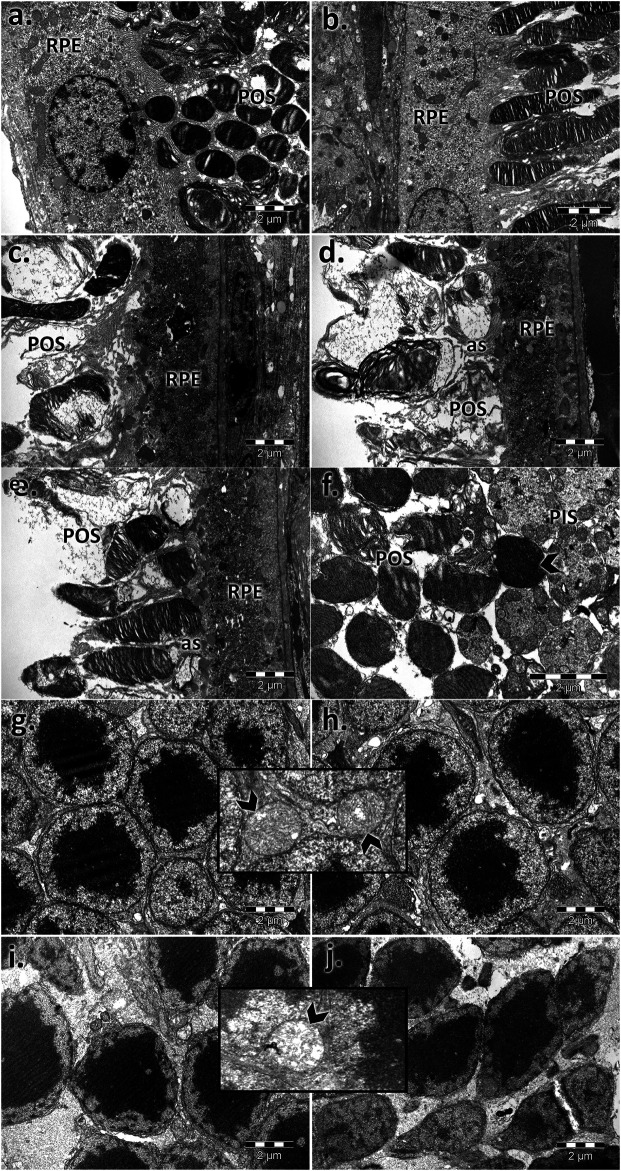
Electron micrographs showing the ultrastructural features of the photoreceptor layer (PS) and outer nuclear layer (ONL) of the young and aged retinas. PS of control male (A) and female (B) mice; PS of aged male (C,D) and female (E,F) mice; ONL of control male (G) and female (H) mice; ONL of aged male (I) and female (J) mice; photoreceptor outer segments with aligned discs and normal structure (A,B); RPE, retinal pigment epithelial layer; ONL, outer nuclear layer; POS, photoreceptor outer segments; the POS are misoriented, damaged, and inconsistent and accompanied by apical sheaths (as) of the epithelial cells (c, d, and E) and condensed (F); photoreceptor outer (POS) and inner segment layer (PIS); normal aspect of the photoreceptor nuclei, aligned and densely packaged (G and H) with the normal aspect of the mitochondria (detail—arrowhead); photoreceptor nuclei with different sizes and chromatin density and empty spaces; swelling of mitochondria with a loss of cristae (detail—arrowhead) (I and J). Figures are representative of n = 10 electron micrographs for each individual/group.